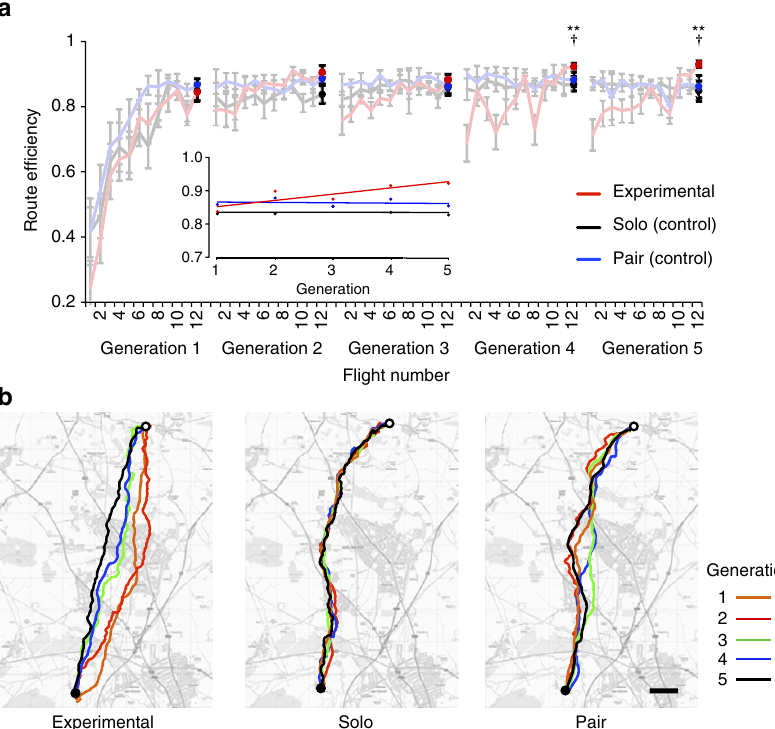
Figure 2 | Changes in homing efficiency over five generations. ( a ) Homing efficiency for all flights in the experimental group (red), the solo control group (black) and the fixed-pair control group (blue). The final (twelfth) flight of each generation in the experimental group and the equivalent (twelfth, twenty- fourth, thirty-sixth, forty-eighth and sixtieth) flights in the control groups are highlighted as bold symbols. Mann–Whitney–Wilcoxon test: ** P o 0.01 and w P o 0.05, for the solo versus experimental comparison and for the fixed-pair versus experimental comparison, respectively. Error bars show s.e.m. Inset shows linear mixed-effects model fitted to the final flights of each generation for all three treatment groups. ( b ) Examples of route development in the three treatment groups. The left panel shows final flights performed by each generation (first–fifth) in one chain in the experimental group; middle and right panels show the equivalent flights performed by a solo control bird and a fixed-pair control, respectively. The release point is indicated by a white dot, the home loft by a black dot. Scale bar represents 1km. Map image: OS data r Crown copyright and database right